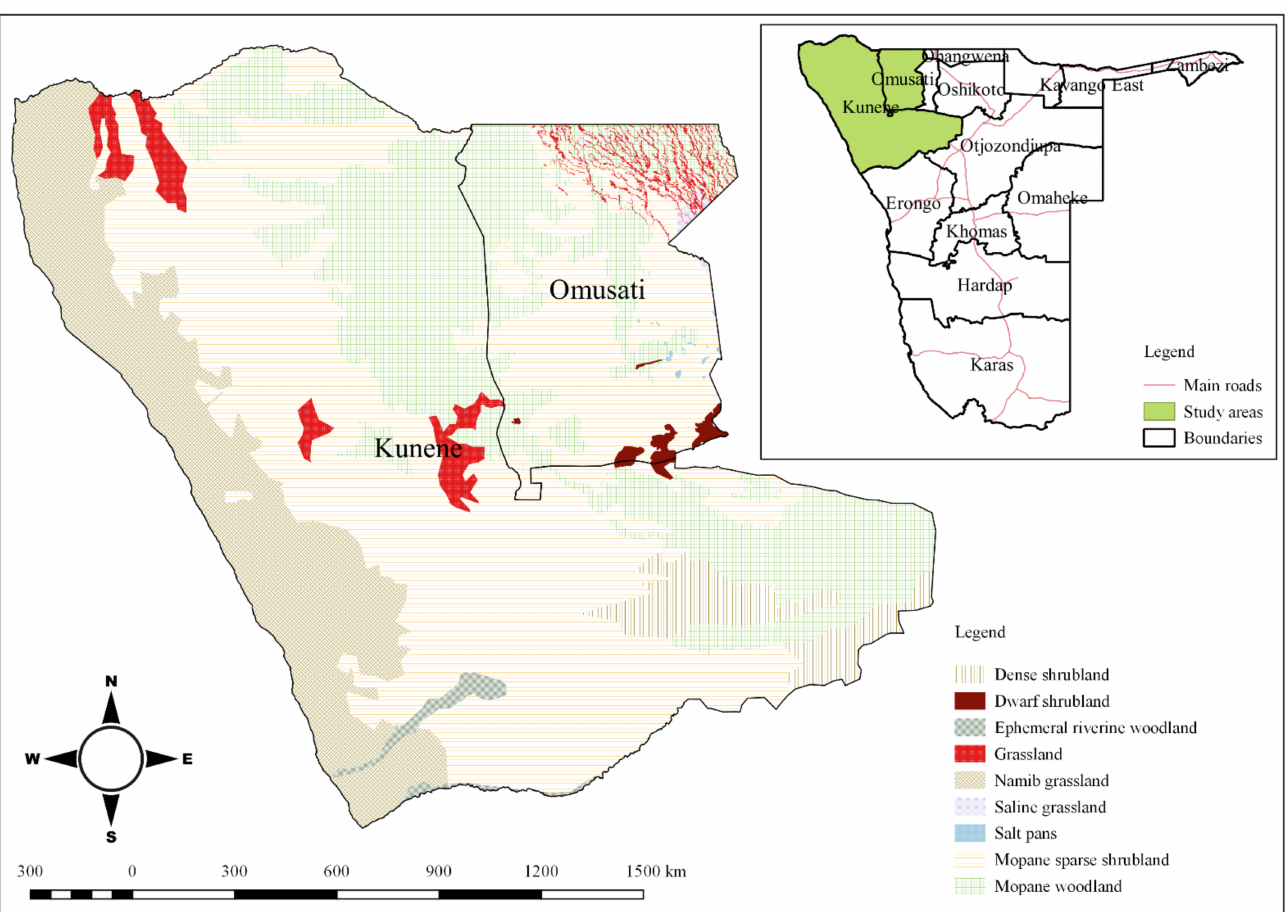
Figure 1. The location of the Omusati and Kunene regions on the map of Namibia and the distribution of mopane woodlands in northern